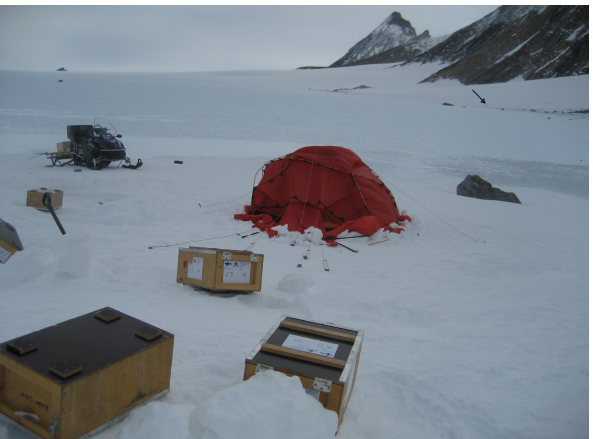
Figure 3. View over the northern inner BIA from the camp (marked with green triangle in Fig. 1) looking towards the north-west, show- ing the destruction after the storm of 2–3 January 2007. The ar- row shows the location where the destroyed tent from the camp was found (magenta triangle in Figs. 1 and 2). The photo was taken by J. C. Moore.